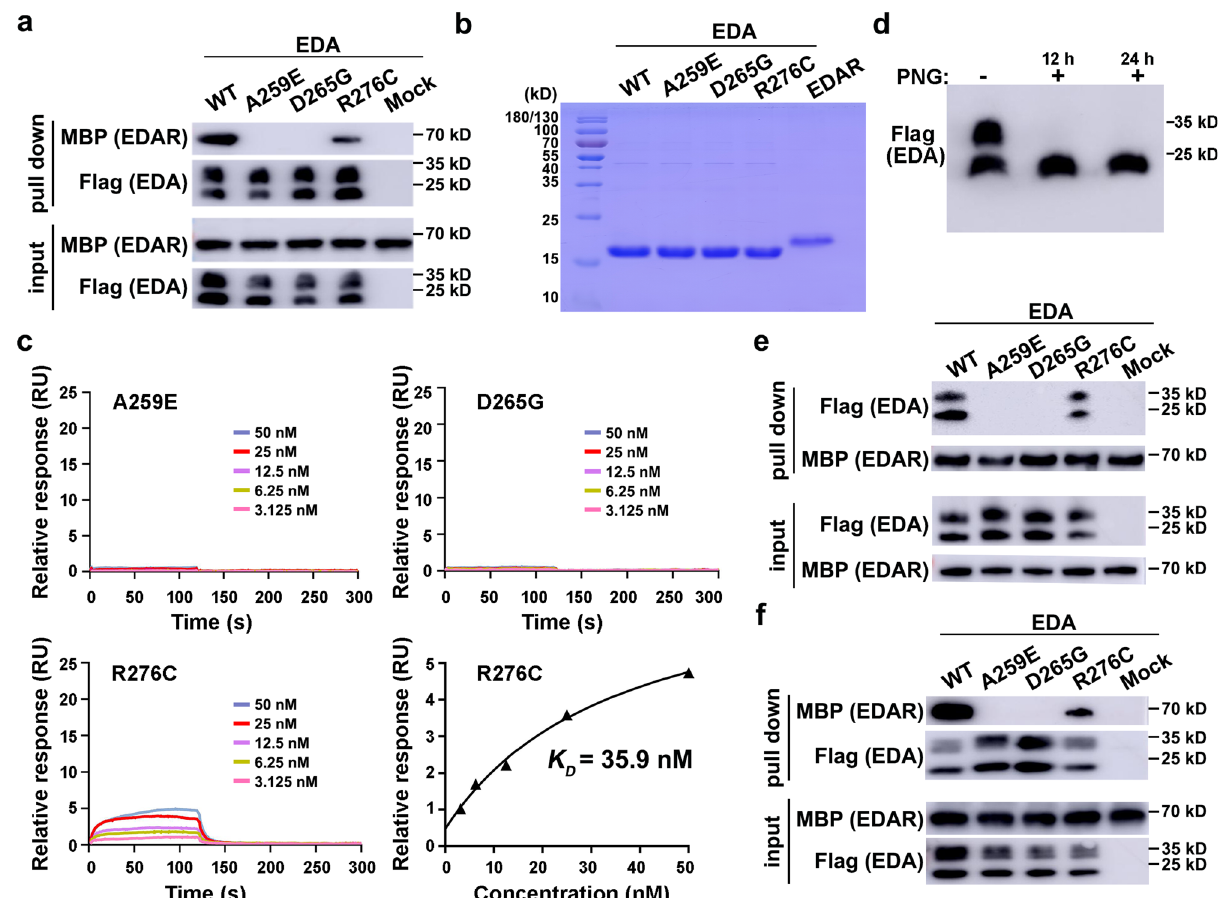
Fig. 4 | Biochemical analysis of mutations at the EDA·A1 THD -EDAR CRDS inter- face. a Pull-down assay using anti-Flag beads with ectopically expressed human Flag-EDA · A1 THD andpuri fi edEDAR CRDS -MBP.Thelevelsofeachproteinintheinput and pull-down samples were analyzed by immunoblotting with the indicated antibodies. The upper and lower bands of Flag-EDA · A1 THD are N-glycosylated and non-N-glycosylatedisoforms,respectively.WT,wildtype;MBP(EDAR),anti-MBPto detect EDAR CRDS -MBP; Flag (EDA), anti-Flag to detect Flag-EDA · A1 THD . b SDS-PAGE analysis of EDA · A1 THD variants and EDAR CRDS . c Surface plasmon resonance mea- surement of binding af fi nity between EDA · A1 THD variants and EDAR CRDS . d Deglycosylation of EDA·A1 THD . Soluble Flag-EDA·A1 THD proteins expressed in the supernatant of HEK293T cells were treated with or without peptide